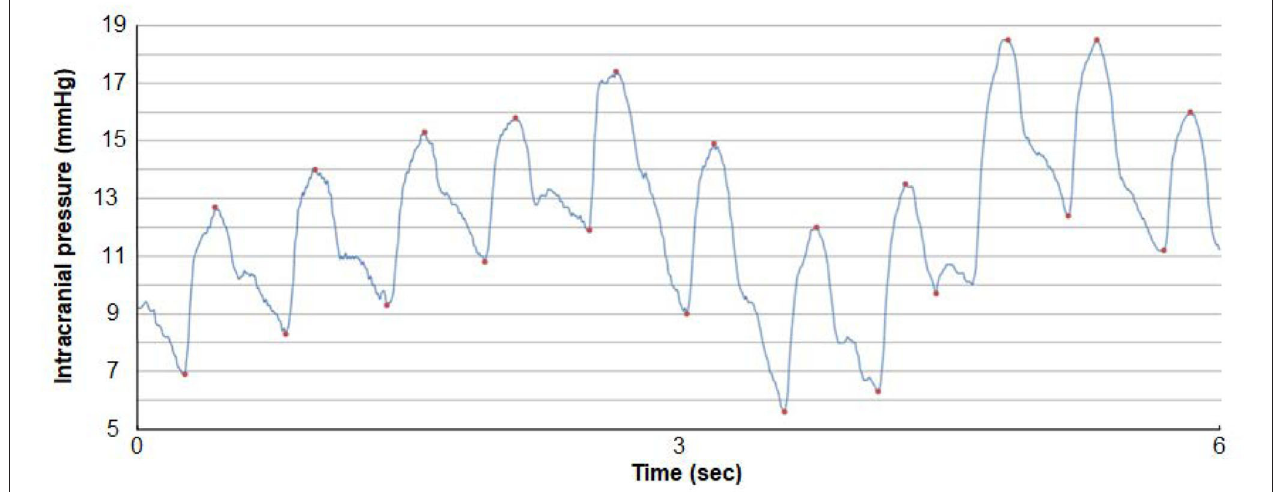
FIGURE 3 | A continuous ICP signal measured from an ICP sensor placed in the frontal parenchyma of an individual with IIH. The level of ICP is shown on the y-axis and time on the x-axis. Both the pulsatile and static ICP are derived from the same ICP signal. The pulsatile ICP is described as the Mean Wave Amplitude (MWA) that refers to the pressure changes occurring during the cardiac cycle, that is, the increase in pressure from diastolic minimum pressure to systolic maximum pressure (here illustrated by the red dots). The mean ICP refers to the static ICP, that is, the absolute pressure measured against a reference pressure. The MWA and the mean ICP are determined over consecutive 6-s time windows; here mean ICP is 12.2 mmHg and MWA 6.4 mmHg. Image: Sensometrics Analytics, dPCom, Oslo, Norway.